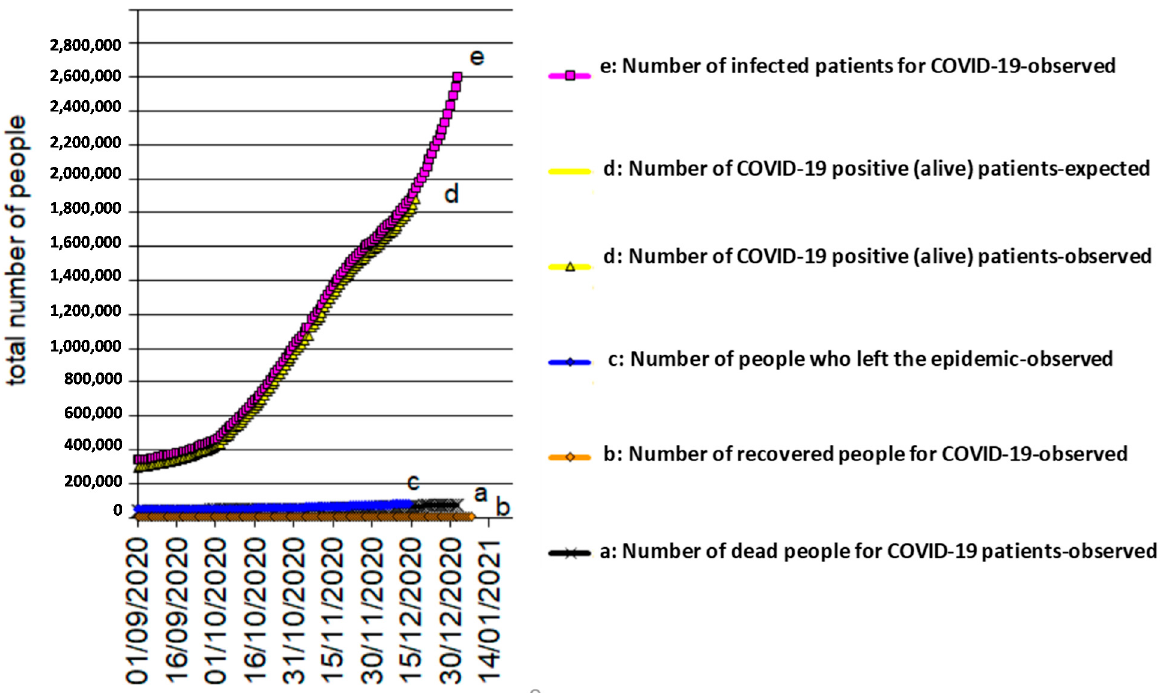
Figure 6. COVID-19 epidemic time-course in UK during the second wave. To illustrate, Figure 7 shows, for Italy, two predictive situations based on ineffective (red triangles above the yellow line) and effective (green triangles below the yellow line) anti-COVID-19 measures. This last will happen when the population uses adequate per- sonal protective equipment, social distancing, and COVID-19 vaccination during the COVID-19 pandemic.